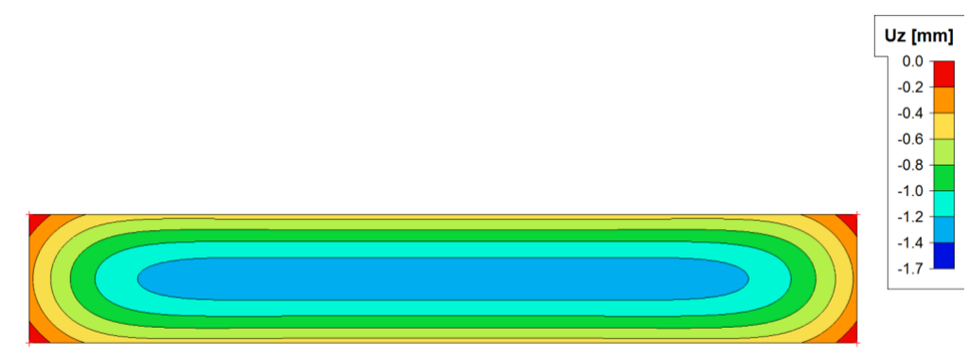
Fig. 6 Deflection of floor pane (intact